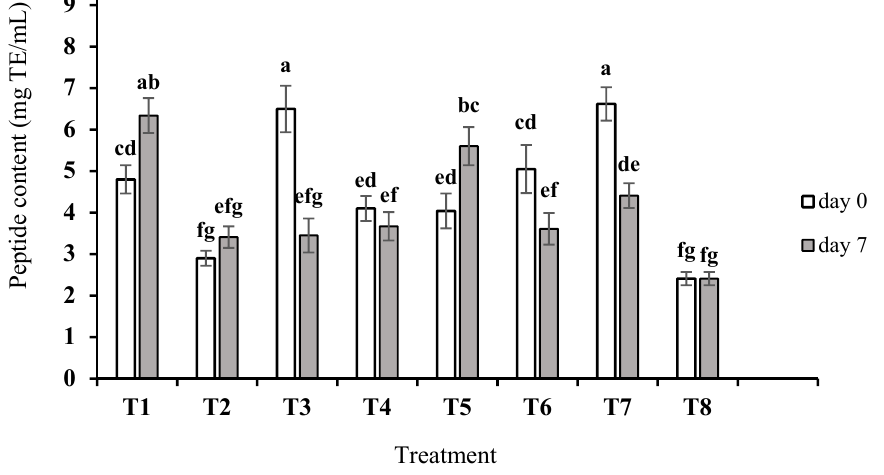
Figure 1. Proteolysis extent based on peptide content equivalent to tryptone in fermented milk samples after fermentation (day 0) and after 7 days of storage. T1, T2, and T3 indicate fermented milk with L. delbruekii subsp. bulgaricus ORT2, L. reuteri SRM2, and L. lactis subsp. lactis BRM3, respectively; T4: fermented milk with L. delbruekii subsp. bulgaricus ORT2 and L. reuteri SRM2; T5: fermented milk with L. delbruekii subsp. bulgaricus ORT2 and L. lactis subsp. lactis BRM3; T6: fermented milk with L. lactis subsp. lactis BRM3 and L. reuteri SRM2; T7: fermented milk with L. delbruekii subsp. bulgaricus ORT2, L. reuteri SRM2 and L. lactis subsp. lactis BRM3; T8: acidified milk with lactic acid. Different letters show significant differences ( p < 0.05) among all the fermented samples during 7 days of storage.